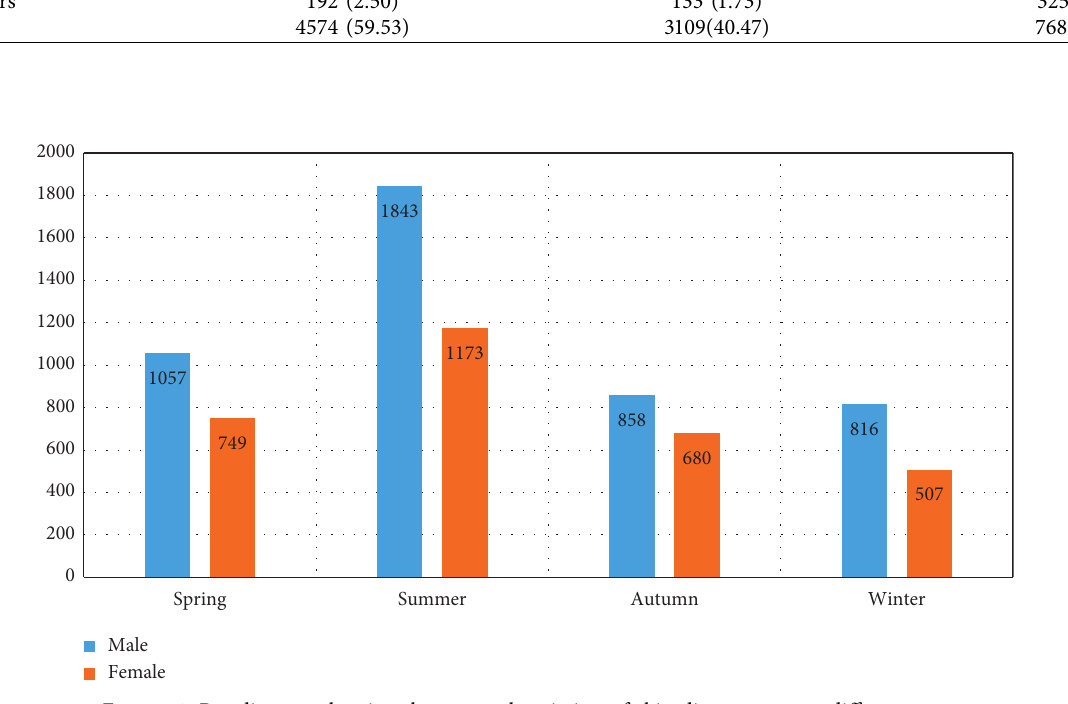
Figure 1: Bar diagram showing the seasonal variation of skin diseases among different